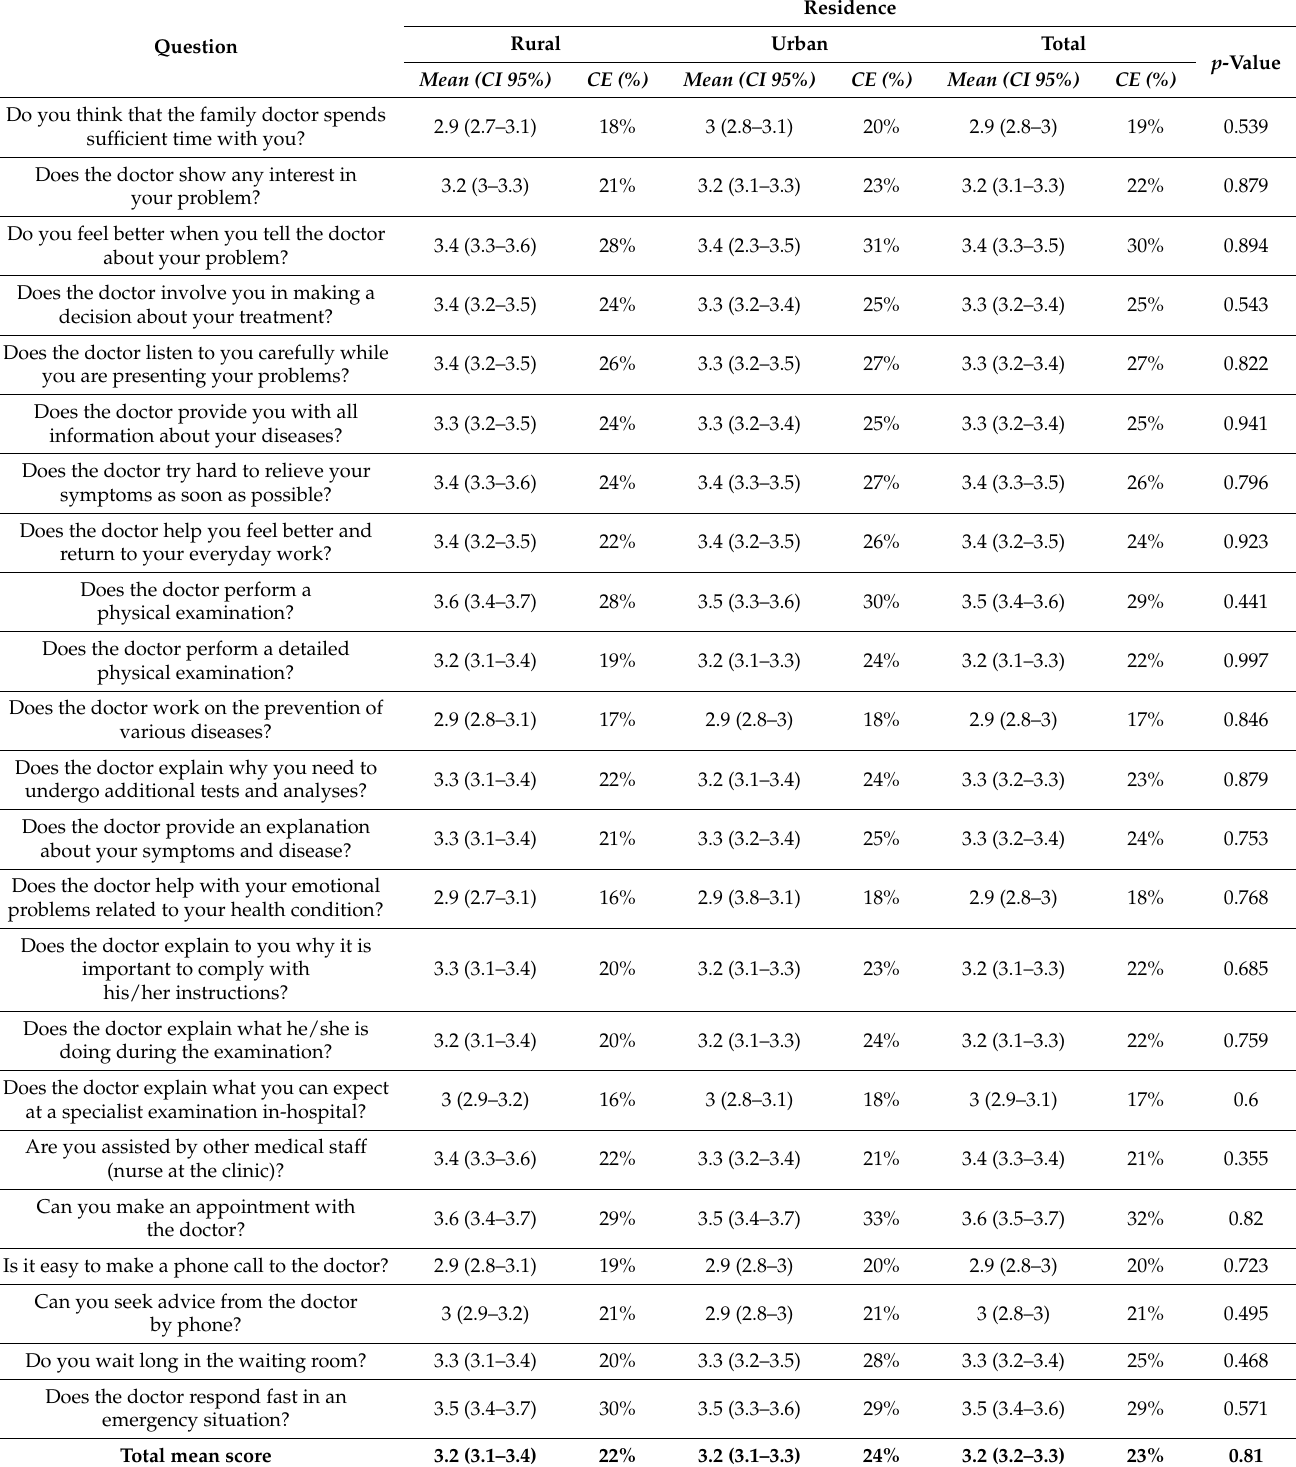
Table 4. Satisfaction with health care in the adult population of the Federation of Bosnia and Herzegovina during the COVID-19 pandemic by